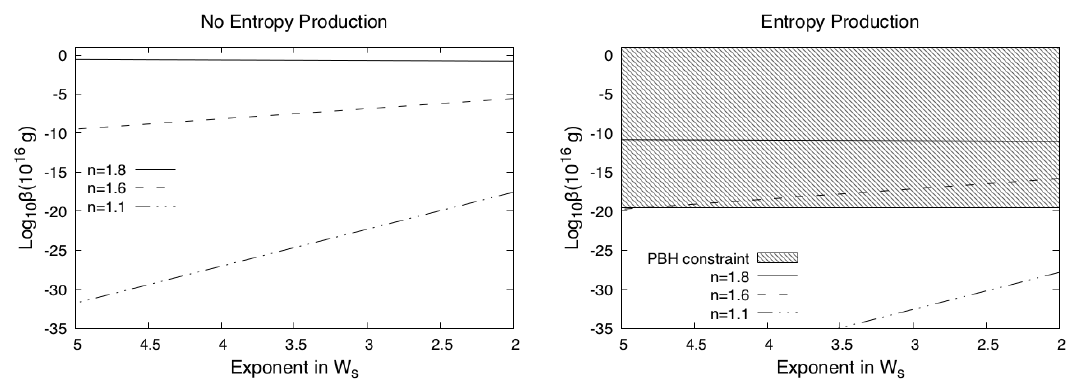
Figure 2 . The mass fraction (cid:12) of PBHs with mass 10 16 g neglecting the entropy production associated with the decay of the scalar (modu- lus), for di(cid:11)erent values of the spectral index n and re(cid:13)ecting the theoretical uncertainties in the formation probability W s . Without dilution, a blue spectrum will generally overproduce these PBHs and be inconsistent with existing observa- tions (compare with (cid:12)gure 3).